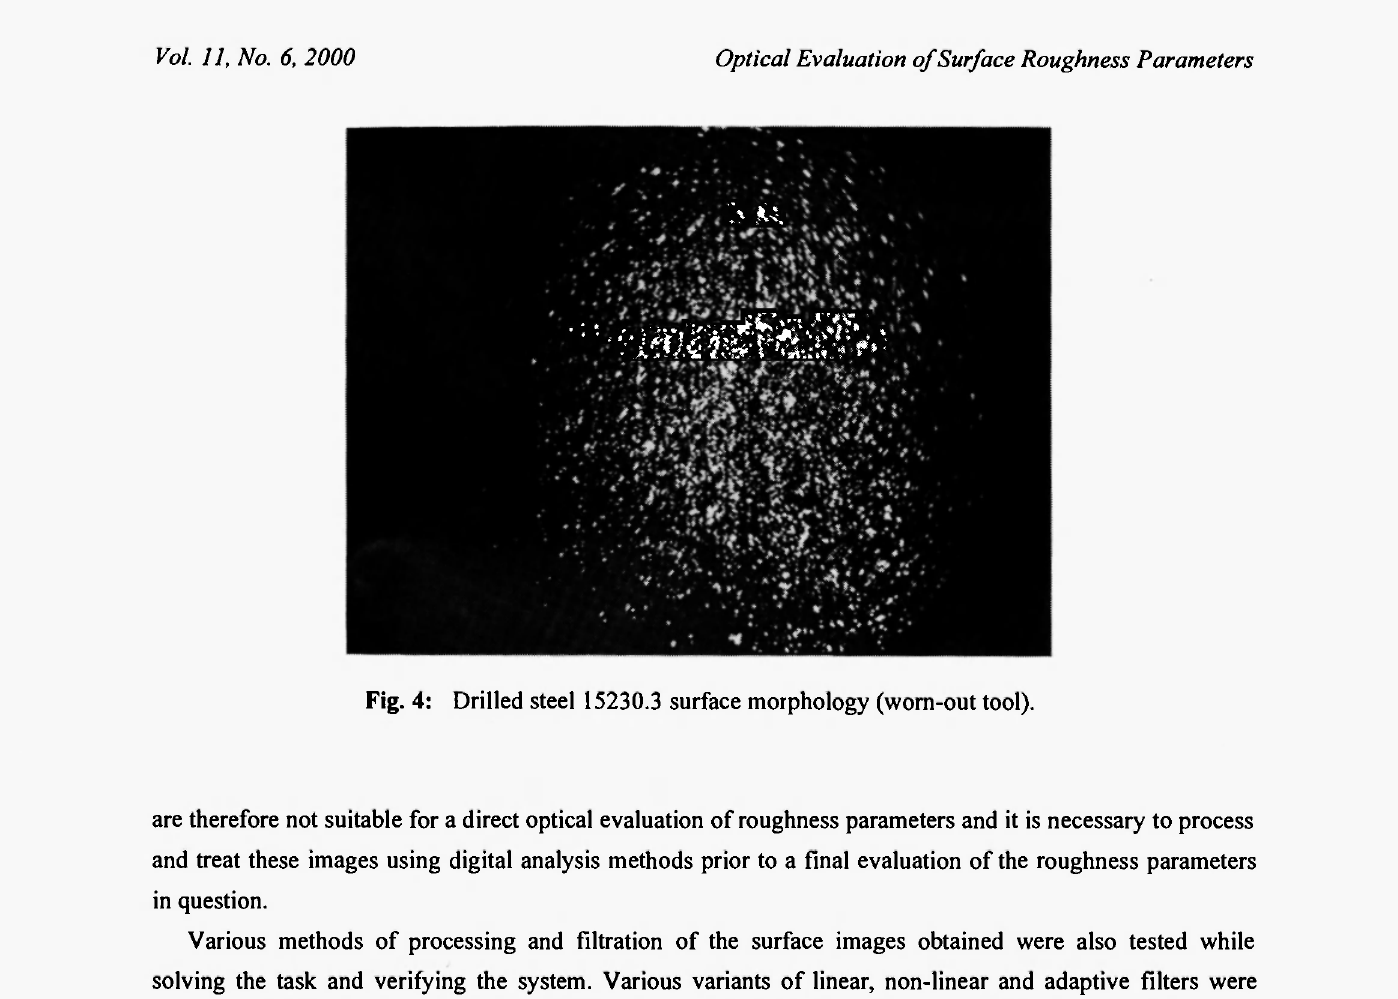
Fig. 4: Drilled steel 15230.3 surface morphology (worn-out